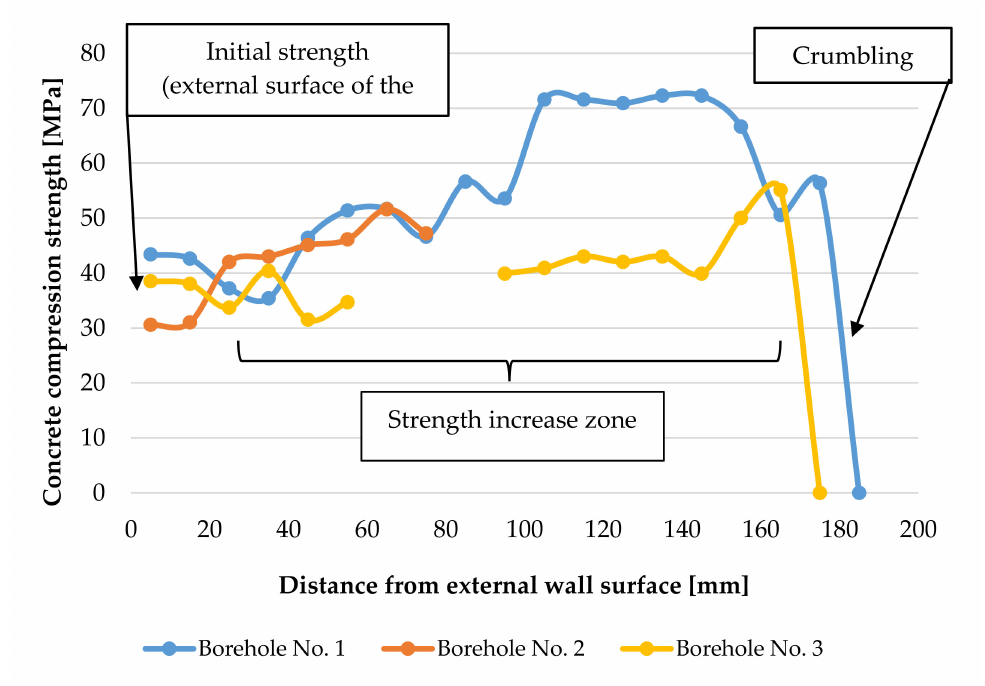
Figure 11. Change of concrete strength across the tank wall thickness in three